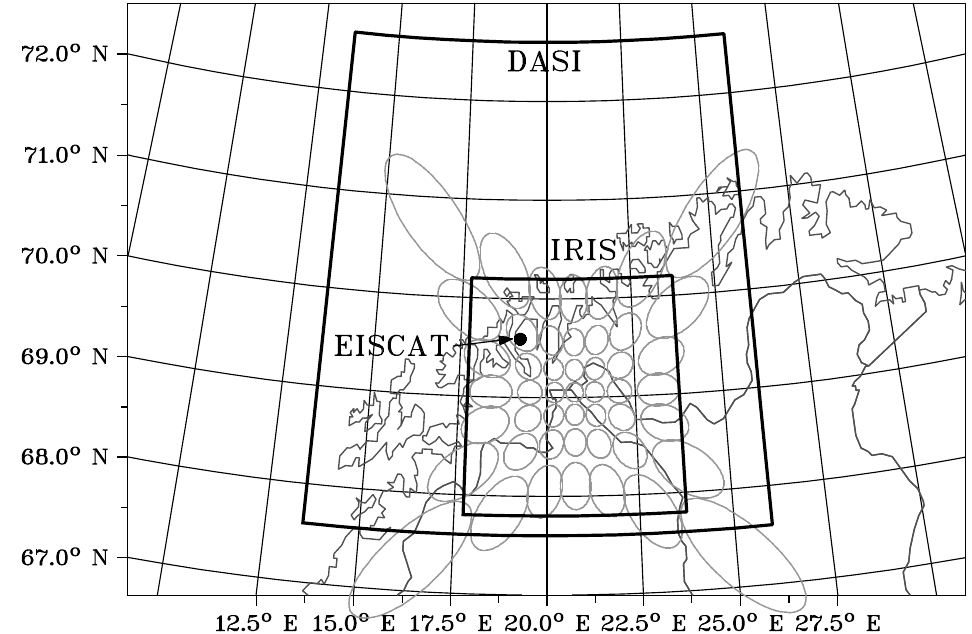
Fig. 1. A geographic map of northern Scandinavia showing the field of view of the Digital All-Sky Imager (DASI) processed data (large trapezium), the field of view of the Imaging Riometer for Ionospheric Studies (IRIS) processed data (small trapezium), the IRIS beam pattern projected up to 90km altitude (ellipses), and the EISCAT radar’s position projected up the magnetic field line to 100km